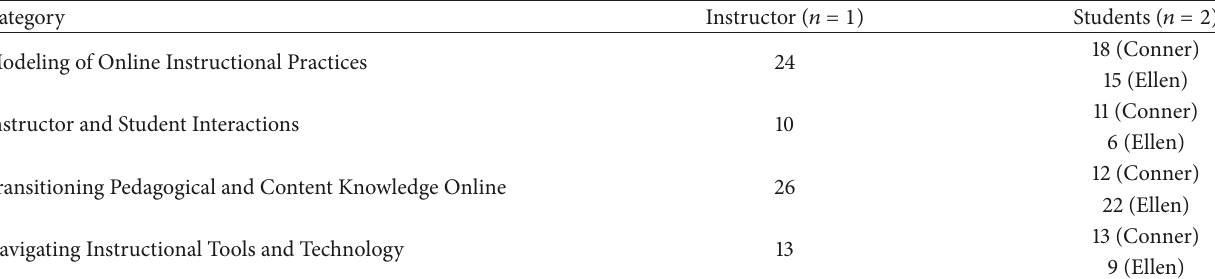
Table 2: Total interview recording